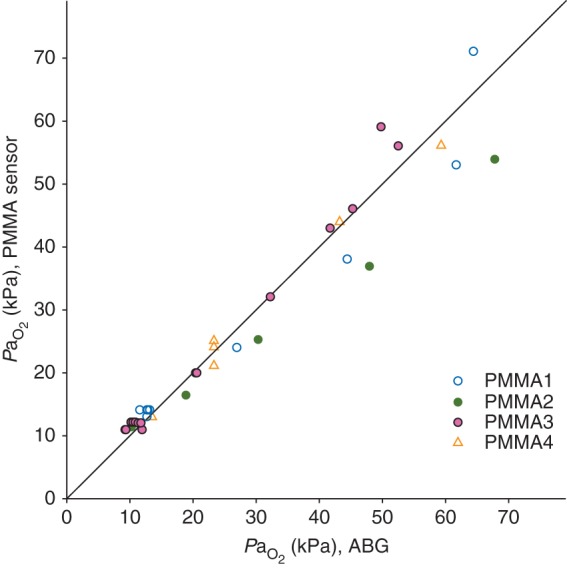
PMMA sensor PaO2 results (average value for 2 s) plotted against standard ABG analysis results (n=39). Sensors coded PMMA1, PMMA2, and PMMA3 were used in the ovine models; sensor PMMA4 was used in the porcine model. The identity line illustrates the degree of agreement between ABG analysis and the PMMA sensor.